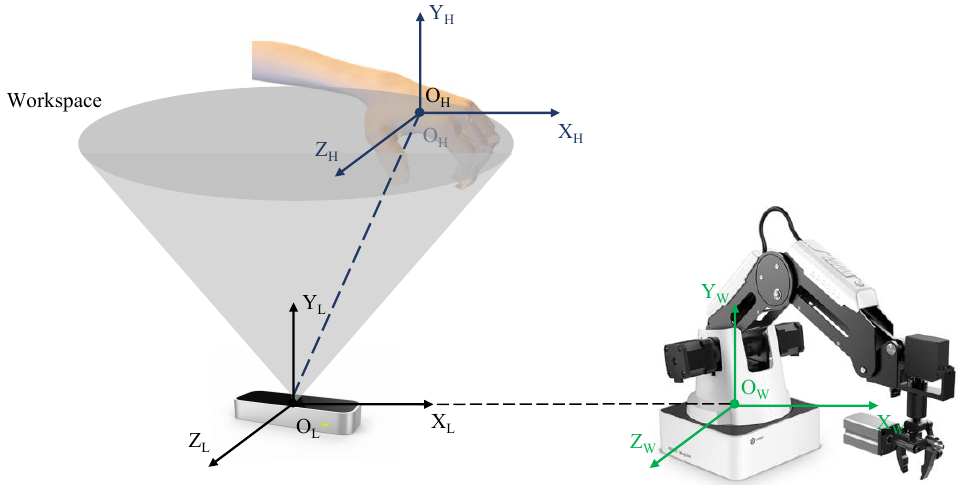
Figure 2. Hand tracking coordinate